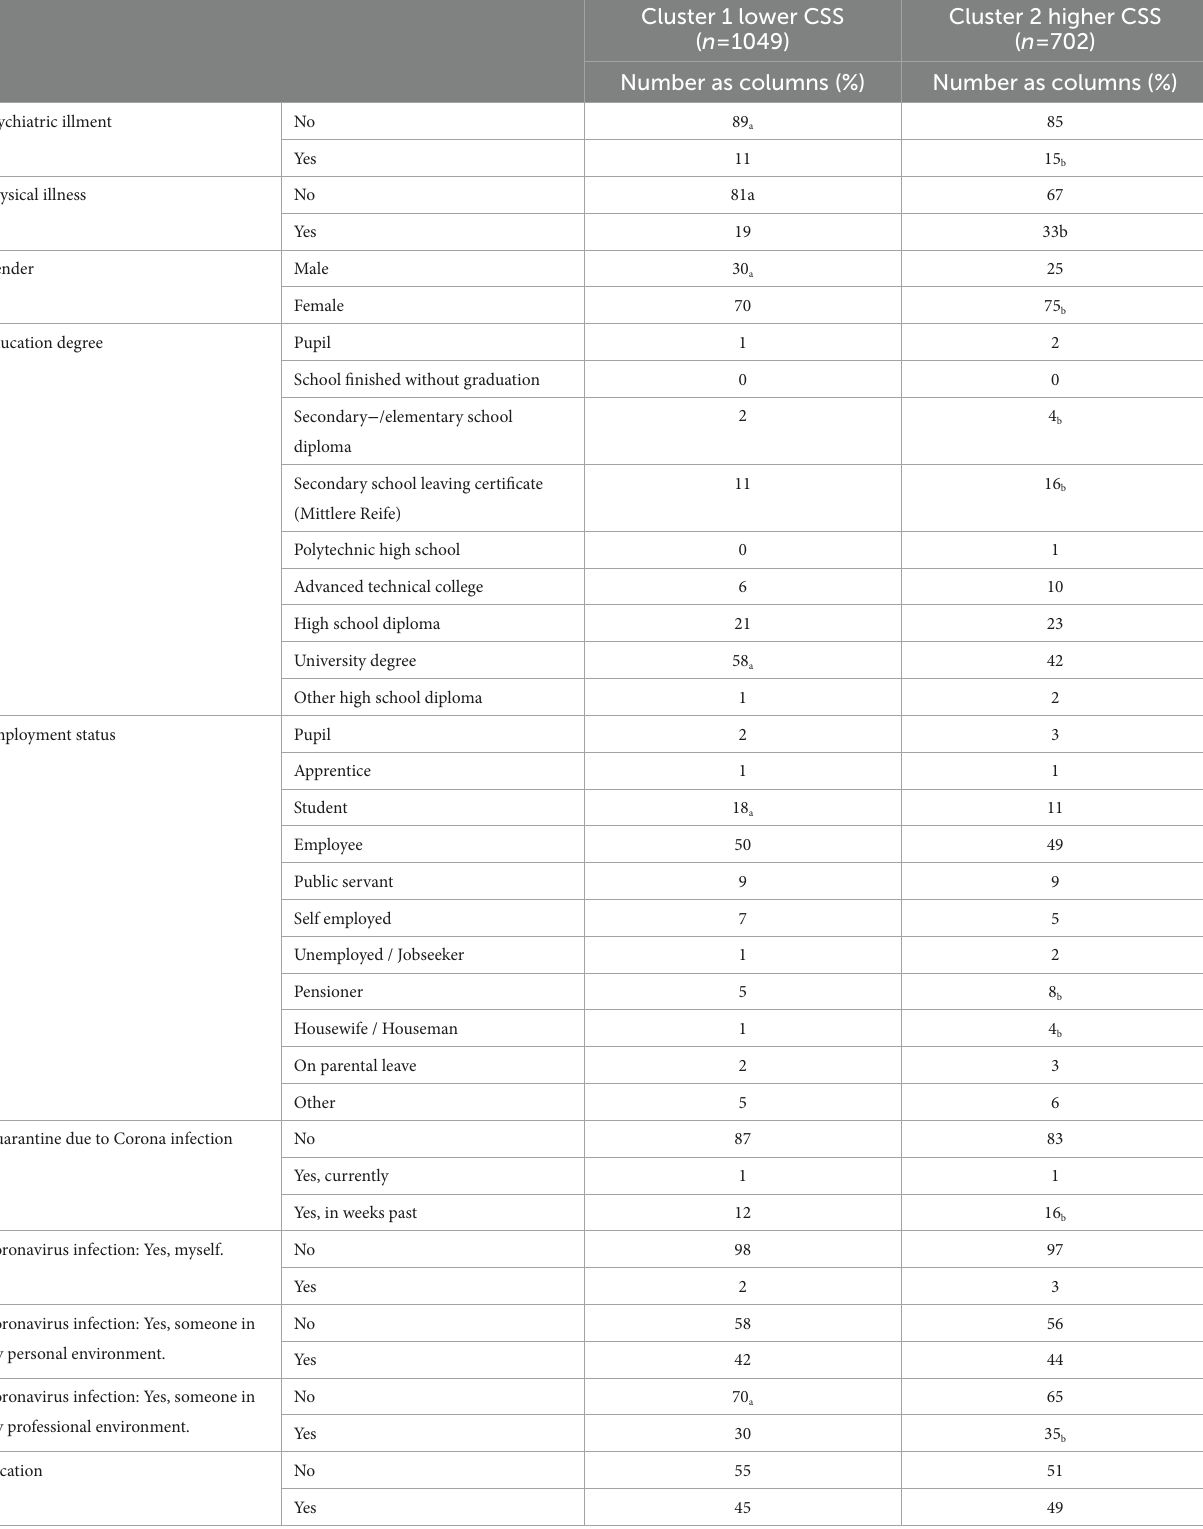
TABLE 4 Cross tabulation of column proportion tests for sociodemographic characteristics between lower CSS and higher CSS.